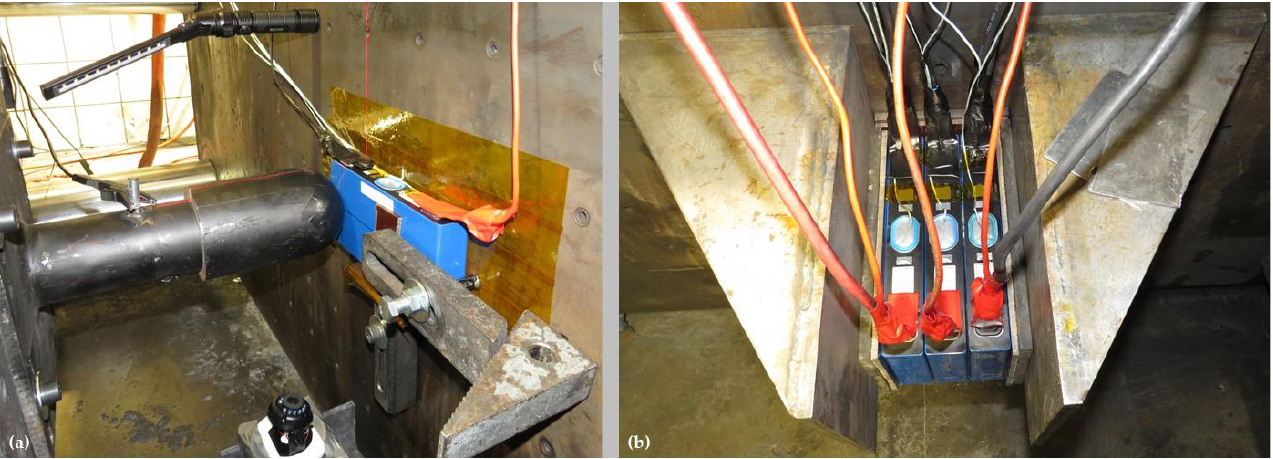
Figure 1. Test setting for static crush test ( a ) u-direction with one cell; ( b ) v-direction with three cells.